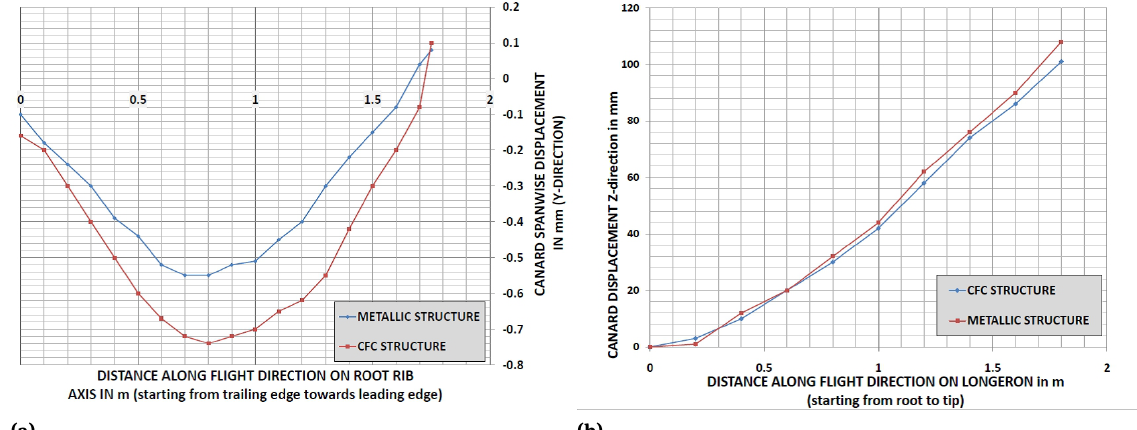
Figure 10: (a) Span-wise Deflection (b) Vertical Deflection